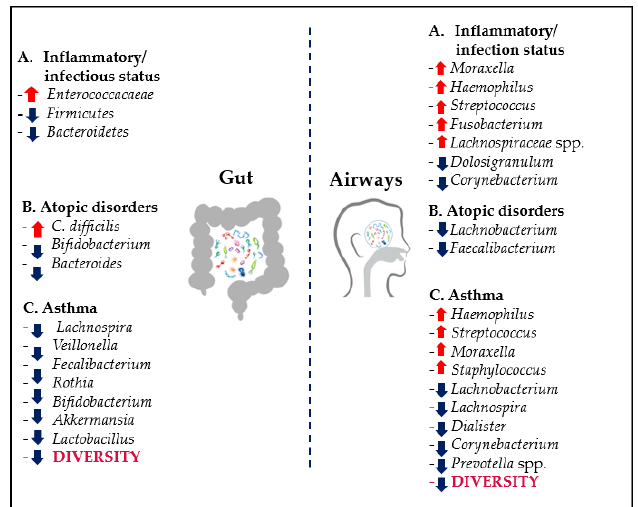
Figure 7. Overview of the main associations between changes in relative abundance of taxa in both gut and airways in children, and RTIs/inflammation, atopic disorders and asthma. Arrow up = increase. Arrow down = decrease